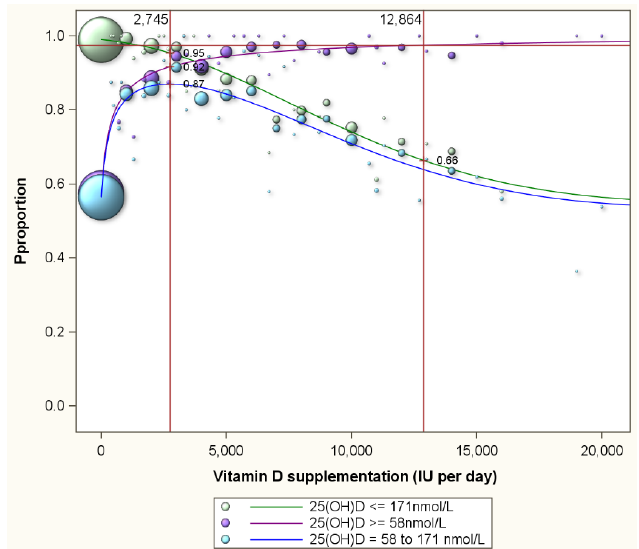
Figure 3. Proportion of participants with serum 25(OH)D concentrations above the lower natural limit, below the upper natural limit and within the natural range. Note: The purple line represents the proportion of individuals with serum 25(OH)D concentrations of 58 nmol/L or more by vitamin D supplementation level; the green line the proportion of participants with concentrations of 171 nmol/L or less; and the blue line the proportion of participants that have serum concentrations above 58 nmol/L and below 171 nmol/L. The blue line is curved and shows that the proportion above 58 nmol/L and below 171 nmol/L peaks at 87% at a supplementation dose of 2745 IU per day. At this optimal dose, 8% (100%–92%) will have serum